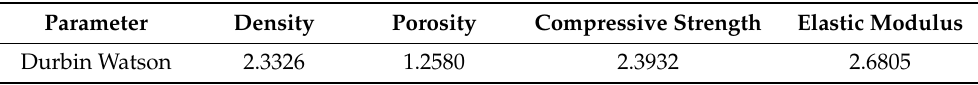
Table 15. Durbin Watson coefficient of multiple linear regression